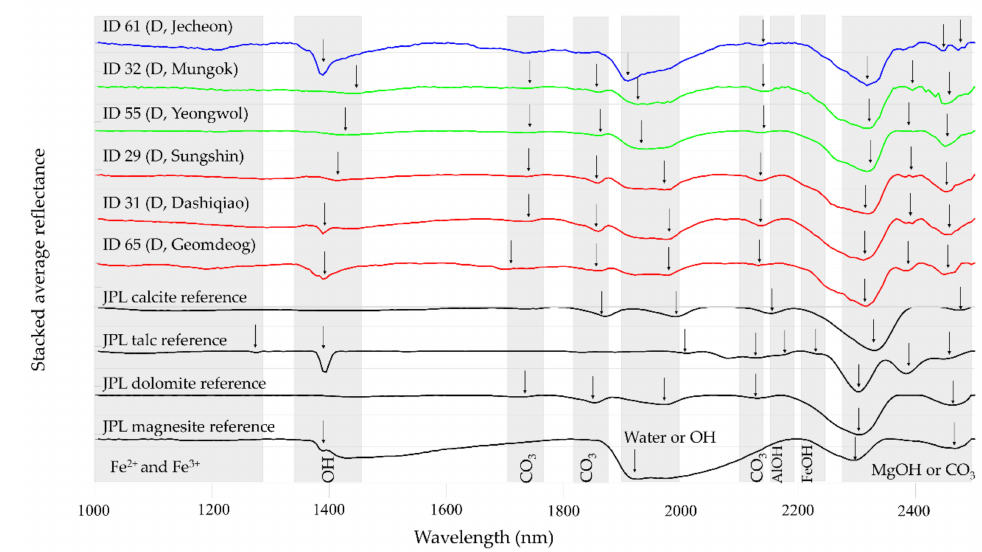
Figure 2. The average hull quotient corrected reflectance spectra of 3 groups of dolomite sample pixels (red = group 1; green = group 2; blue = group 3) compared with library reference spectra.